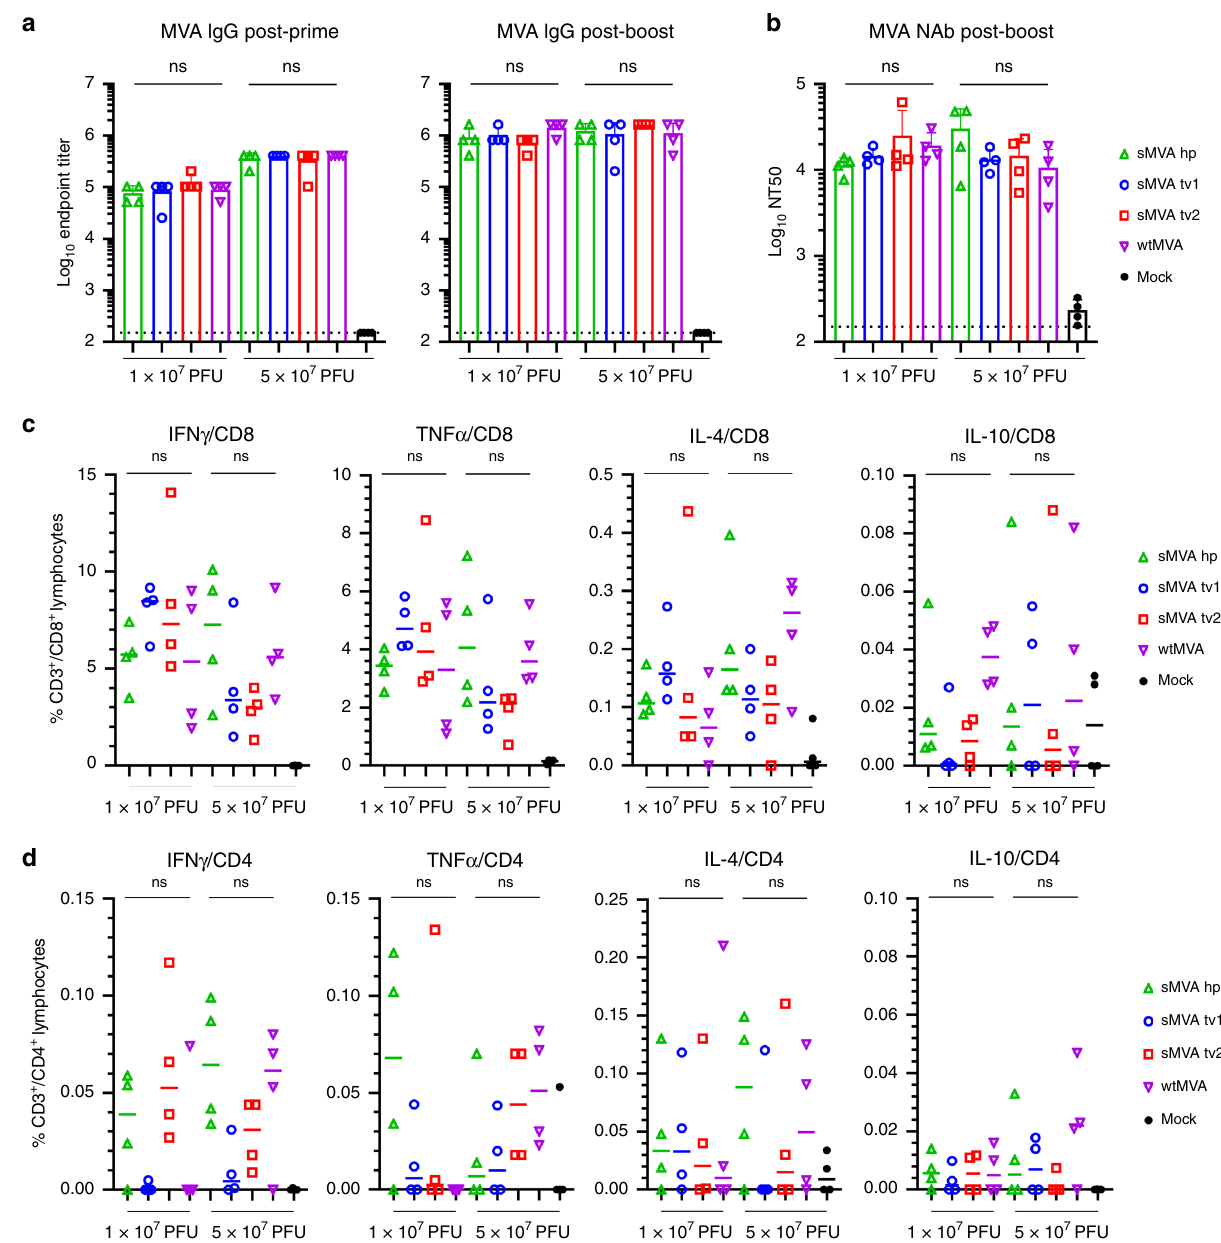
Fig. 3 sMVA in vivo immunogenicity. sMVA derived either with FPV HP1.441 (sMVA hp) or with FPV TROVAC from two independent virus reconstitutions (sMVA tv1 and sMVA tv2) was compared by in vivo analysis with wtMVA. C57BL/6 mice ( n = 4) were immunized twice at a 3-week interval with low (1 × 10 7 PFU) or high (5 × 10 7 PFU) dose of sMVA or wtMVA. Mock-immunized mice were used as controls. a Binding antibodies. MVA- speci fi c binding antibodies (IgG titer) stimulated by sMVA or wtMVA were measured after the fi rst and second immunization by ELISA. b NAb responses. MVA-speci fi c NAb titers induced by sMVA or wtMVA were measured after the booster immunization against recombinant wtMVA expressing a GFP marker. c , d T-cell responses. MVA-speci fi c IFN γ , TNF α , IL-4, and IL-10-secreting CD8 + ( c ) and CD4 + ( d ) T-cell responses induced by sMVA or wtMVA after two immunizations were measured by fl ow cytometry following ex vivo antigen stimulation using B8R immunodominant peptides. Differences between groups were evaluated using one-way ANOVA with Tukey ’ s multiple comparison test; ns = not signi fi cant ( p > 0.05). Data in a and b are presented as mean values + SD. Lines in c and d represent median values. Source data are provided as a Source Data fi le. were comparable to those achieved with sMVA or wtMVA (Del2) site (sMVA-N/S), or they were inserted into Del3 and the (Table S1). PCR and sequencing analysis of the Del2, Del3, and intergenic region between MVA 069R and 070L (IGR69/70) IGR69/70 MVA insertion sites con fi rmed the integrity and (sMVA-S/N) (Figs. 1b and 4b) 5,41 . All antigen sequences were inserted into sMVA together with mH5 promoter to promote insertion of the SARS-CoV-2 antigen sequences in all sMVA- antigen expression during early and late phases of MVA CoV2 vaccine vectors (Fig. 4c). Moreover, whole-genome replication 42,43 . sMVA-CoV2 vaccine vectors were reconstituted sequencing of all double-recombinant sMVA-CoV2 vaccine with FPV strains HP1.441 or TROVAC. Puri fi ed virus of the vectors — reconstituted either with FPV strain TROVAC or sMVA-CoV2 vectors produced using CEF reached titers that HP1.441 — veri fi ed the reference sequences of these vaccine NATURE COMMUNICATIONS| (2020) 11:6121